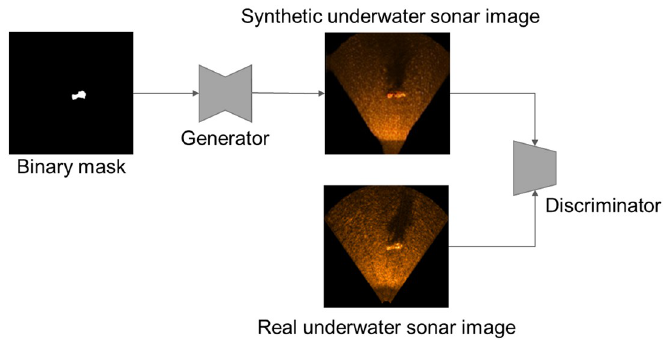
Fig 2. Image translation NN used in the proposed method. The generator generates a synthetic USI from the binary mask; the discriminator distinguishes the real USI and the synthetic USI generated by the generator. The generator and discriminator are trained